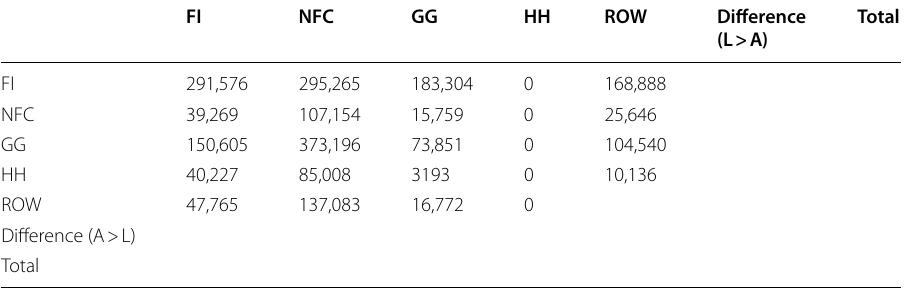
Table 13 Financial Asset/Liability Stocks for which Counterpart Sectors cannot be Identified (in units of 100 million CNY)